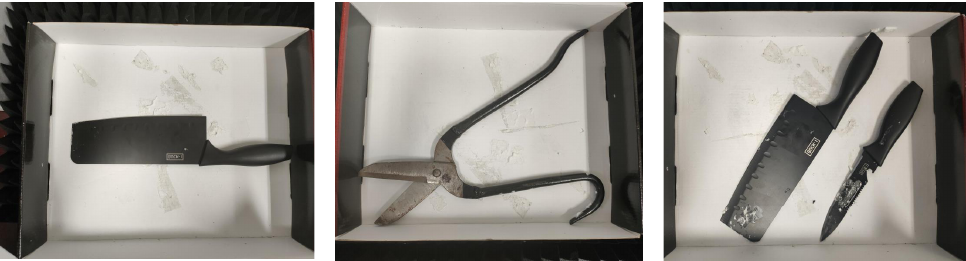
Figure 9. The optical images. Left is a plier; Middle is a stiletto; Right is a hammer.